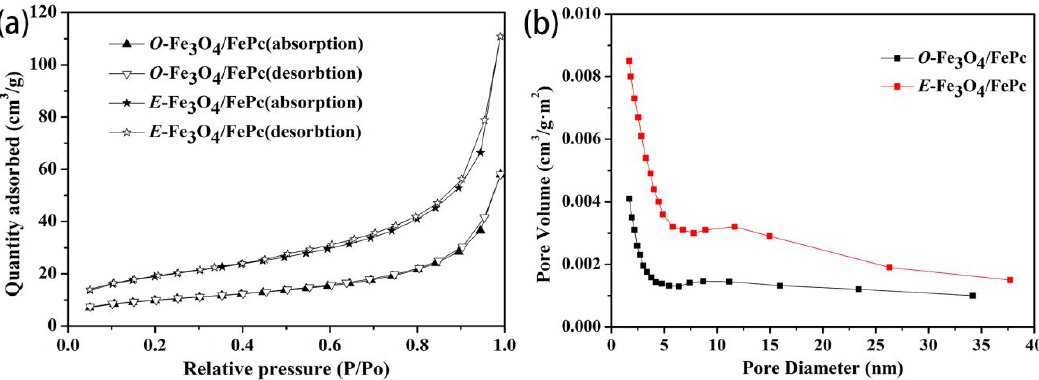
Figure 4. ( a ) N 2 adsorption and desorption isotherms and ( b ) BJH isotherm curves (by adsorption) of O -Fe 3 O 4 /FePc and E -Fe 3 O 4 /FePc.